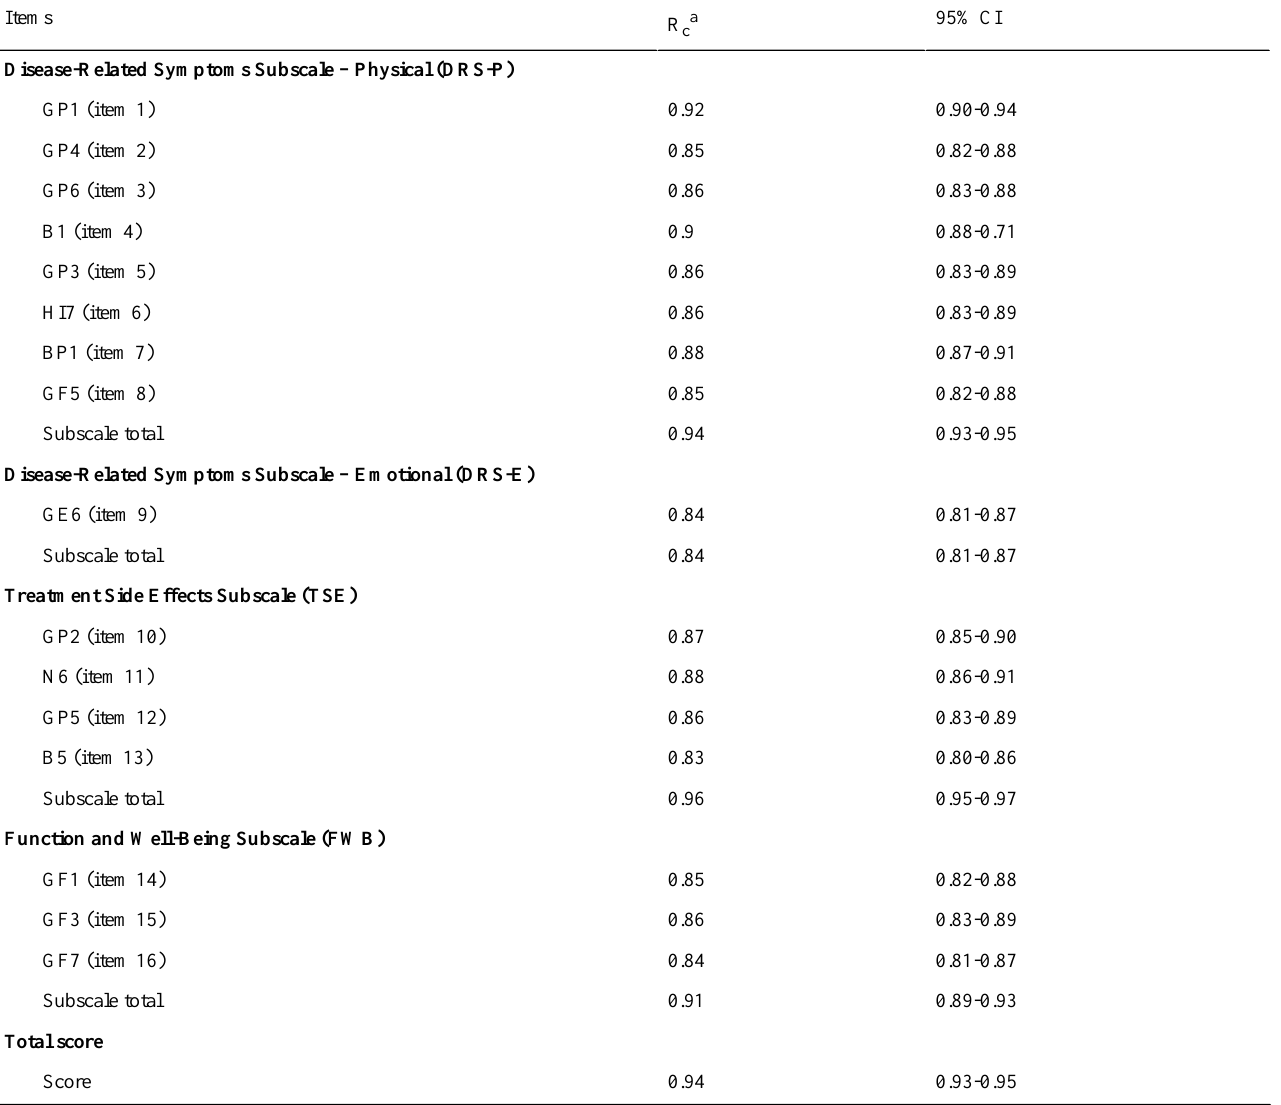
Table 5. Agreement between paper-based and web-based questionnaires scores (Lin concordance correlation coefficient analysis).